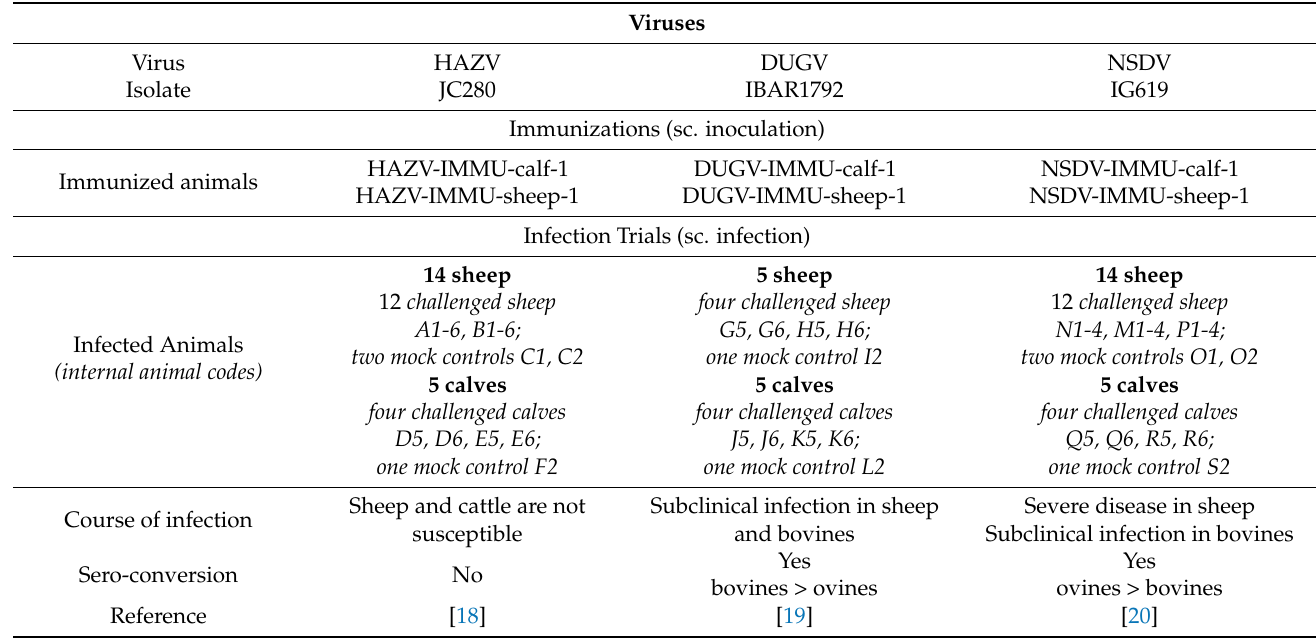
Table 1. Ruminant sera used in this